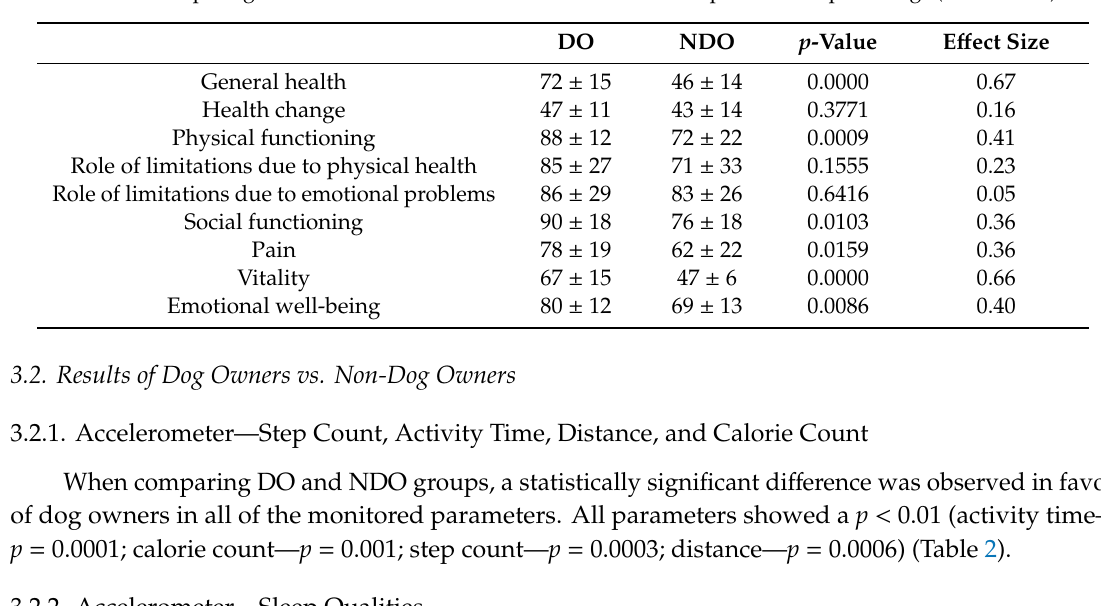
Table 4. ComparingtheDOandtheNDOtakenfromSF-36. Dataarepresentedinpercentage(mean ±